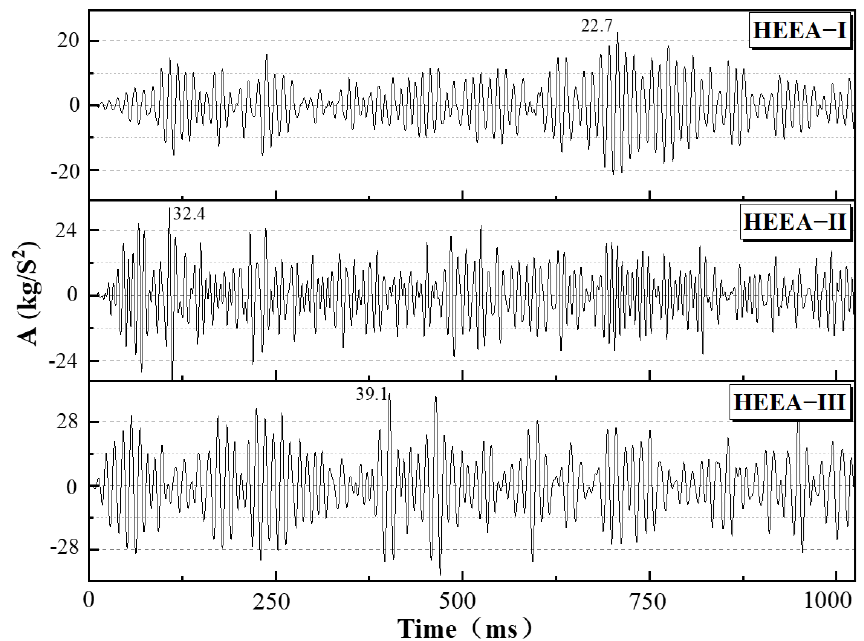
Figure 14. Acoustic emission signal curve of concrete specimen in damage process.